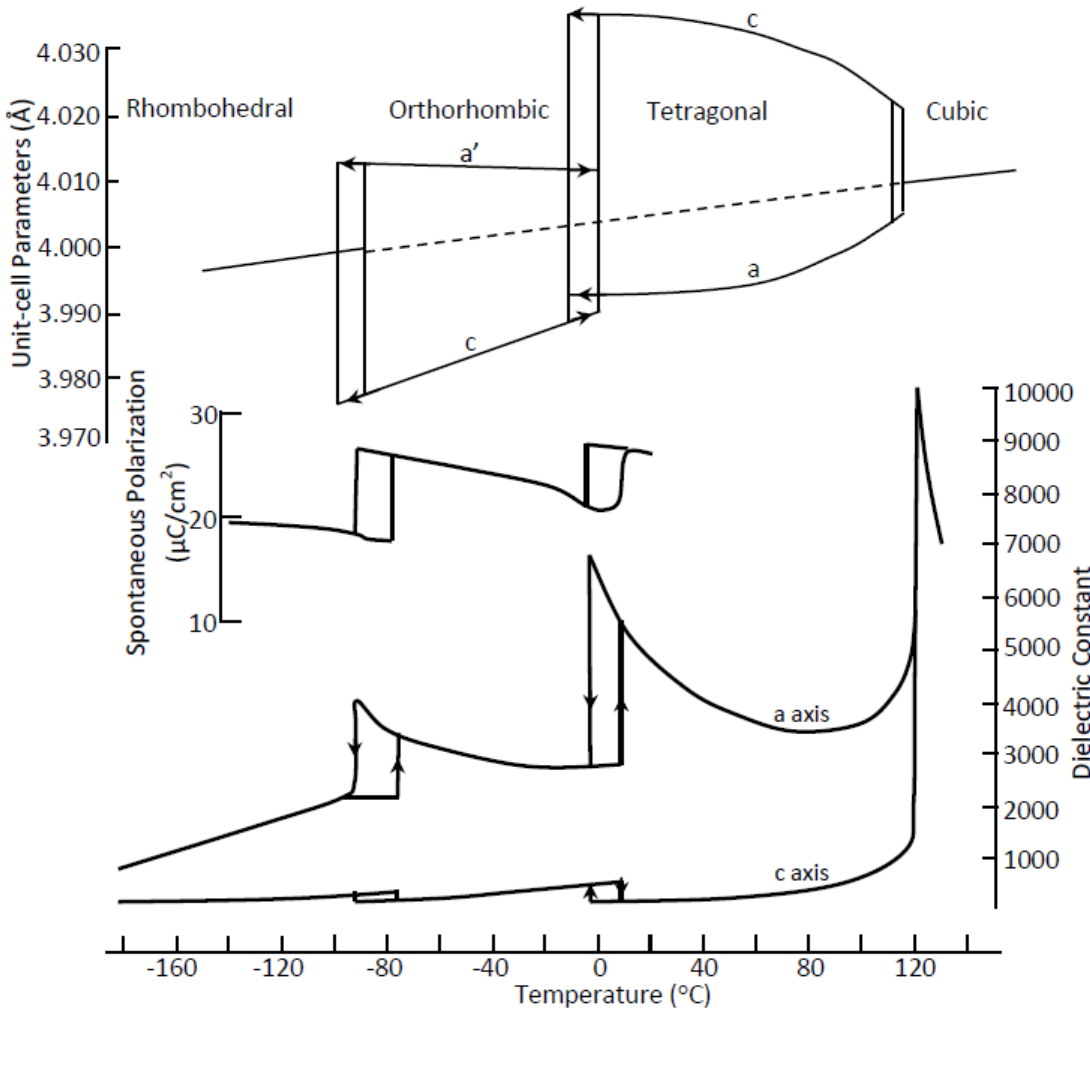
Figure 2. Polymorphic phase transitions in barium titanate single crystals observed through changes in the unit cell parameters [32], spontaneous polarization [33], and dielectric constant [15], reproduced from the respective